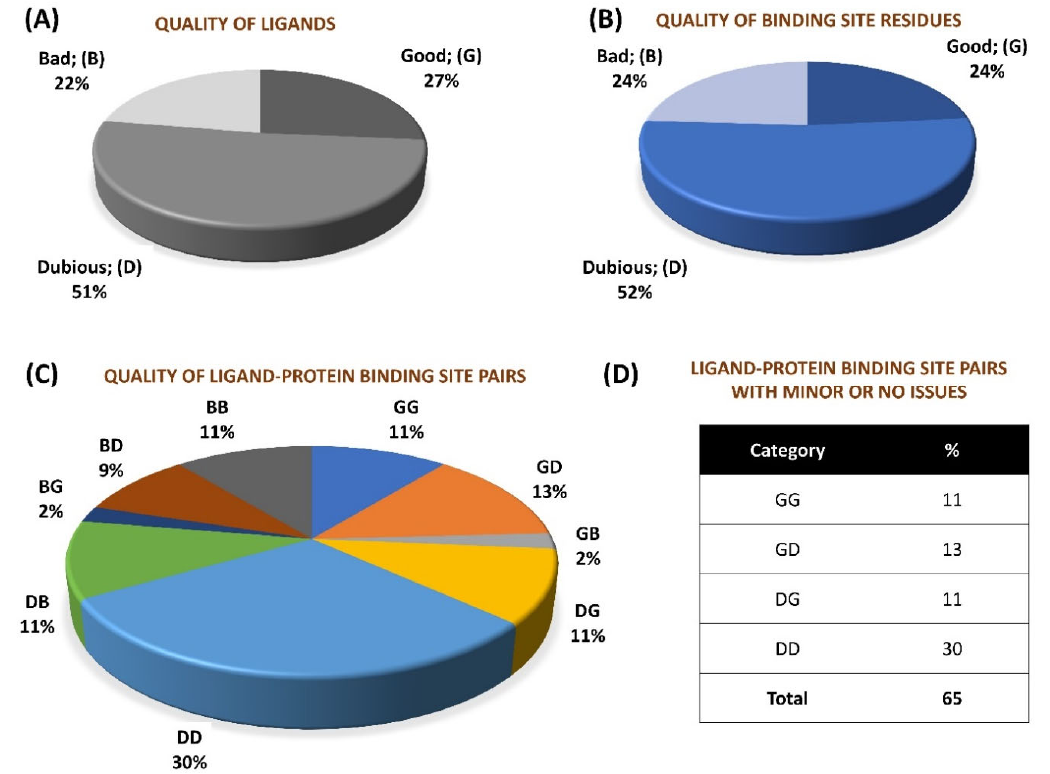
Figure 1. Overall percentage distribution of quality assessment results of 276,377 small molecule–protein binding site pairs in 66,851 PDB entries. ( A ) Percentage distribution of quality categories of ligands. ( B ) Percentage distribution of quality categories of protein binding sites. ( C ) Percentage distribution of quality categories of ligand–protein binding site pairs. ( D ) Chart showing percentage of ligand–protein binding site pairs devoid of ‘Bad’ quality of either ligand/protein binding site.